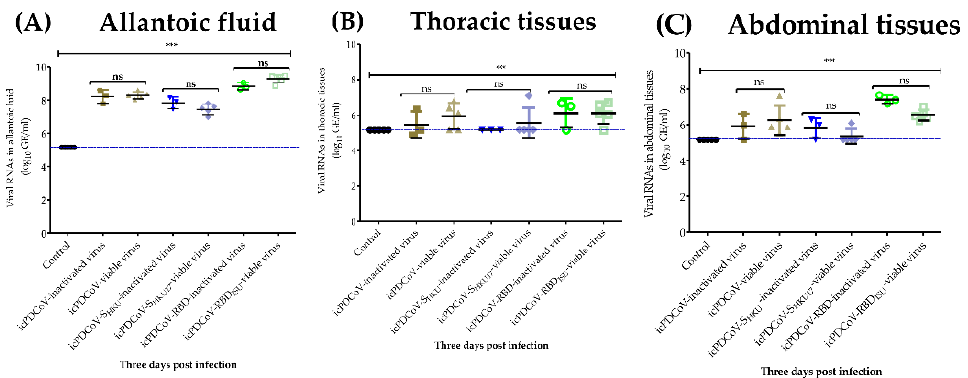
Figure 10. Quantity of viral RNAs in ( A ) allantoic fluids, ( B ) thoracic- and ( C ) abdominal tissues. The 11-day-old embryonated chicken eggs were inoculated with mock-inoculated, or heat-inactivated (at 60 ◦ C for 20 min) or viable icPDCoV, icPDCoV-S HKU17 , and icPDCoV-RBD ISU viruses. Dashed line indicates detection limit of 5.17 log10 GE/mL of viruses in samples. GE, genomic equivalent. One-way ANOVA with Tukey’s multiple comparisons post hoc test, *** p ≤ 0.05, ns; not statistically significant.